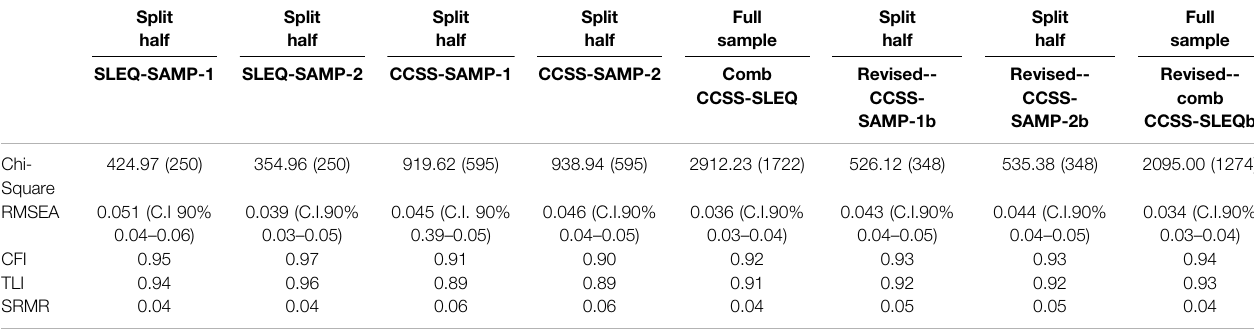
TABLE 2 | Fit for random split-halves and full sample for each SLEQ and CCSS as well as the combined instrument. Split